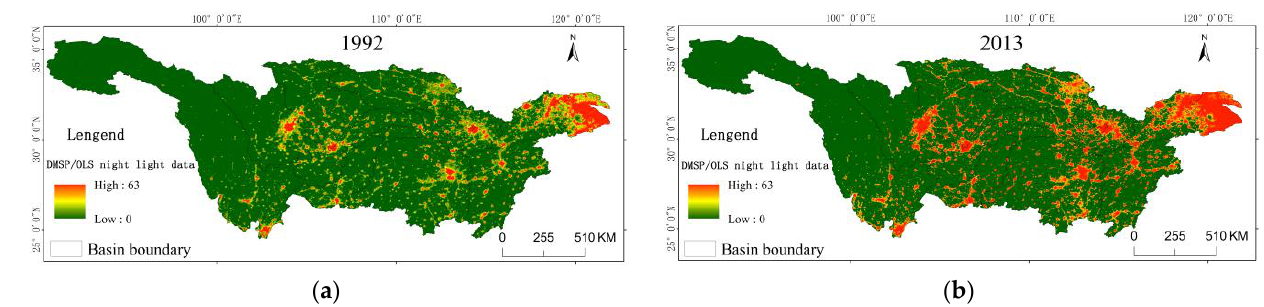
Figure 14. Distribution of DMSP/OLS light data in the Yangtze River Basin. ( a ) is the DMSP/OLS light data in 1992; ( b ) is the DMSP/OLS light data in 2013.